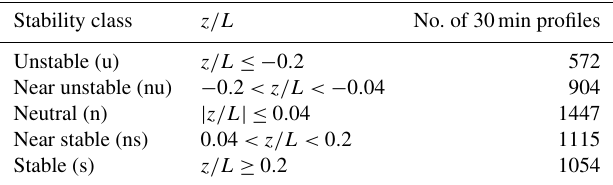
Table 2. Definition of atmospheric stability classes within intervals of z/L and respective quantity of 30min